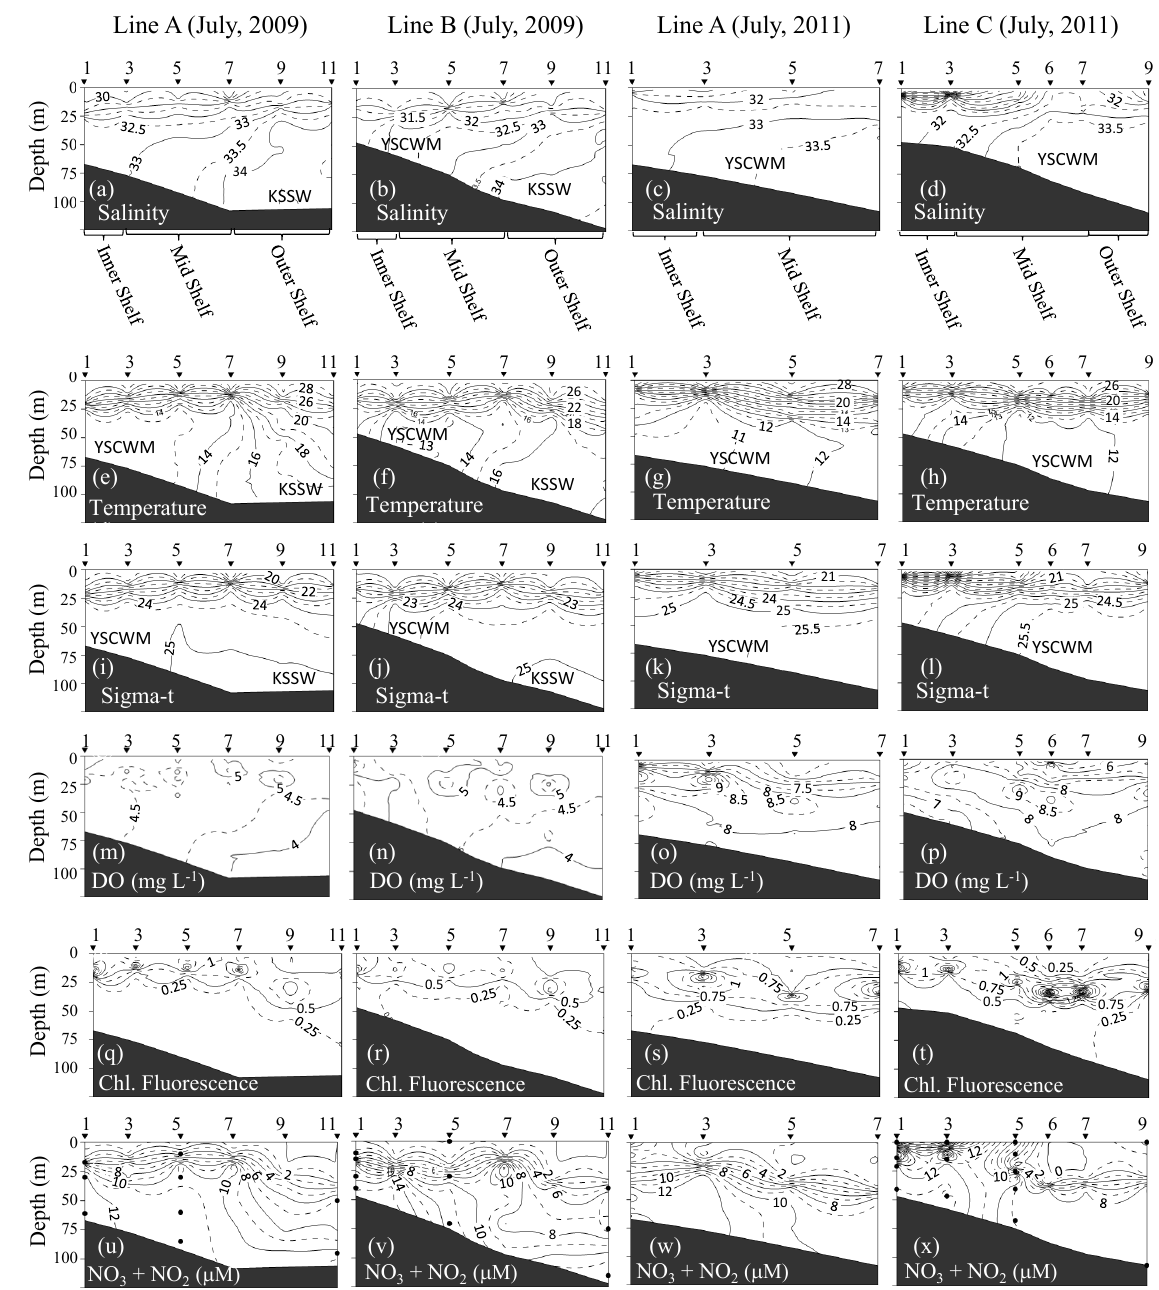
Fig. 3. Vertical distribution of physical parameters, chlorophyll fluorescence, and nitrate concentrations along lines A and B in July 2009 and lines A and C in July 2011. The black circles in the NO 3 +NO 2 figure are the same as in Fig. 2.